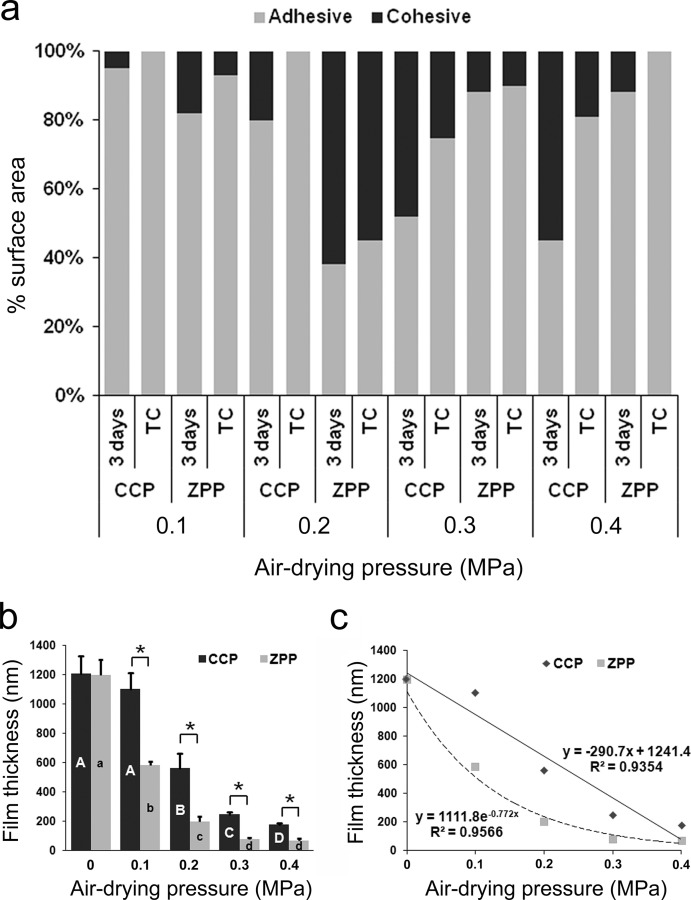
Failure modes analysis and primer film thickness result.(a) Failure modes for the micro-shear bonding test after 3 days of water storage or 5,000 thermocycles. (b) Variation in primer film thickness as a function of air-drying pressure. Data presented are means and standard deviations (n = 6). For CCP subgroups, the same upper case letters represent absence of statistically significant difference (p>0.05). For ZPP subgroups, the same lower case letters represent absence of s statistically significant difference (p>0.05). Asterisks indicate significant differences between the two ceramic primers (p<0.05). (c) Correlations between primer film thickness and air-drying pressure for the CPP and ZPP ceramic primers.